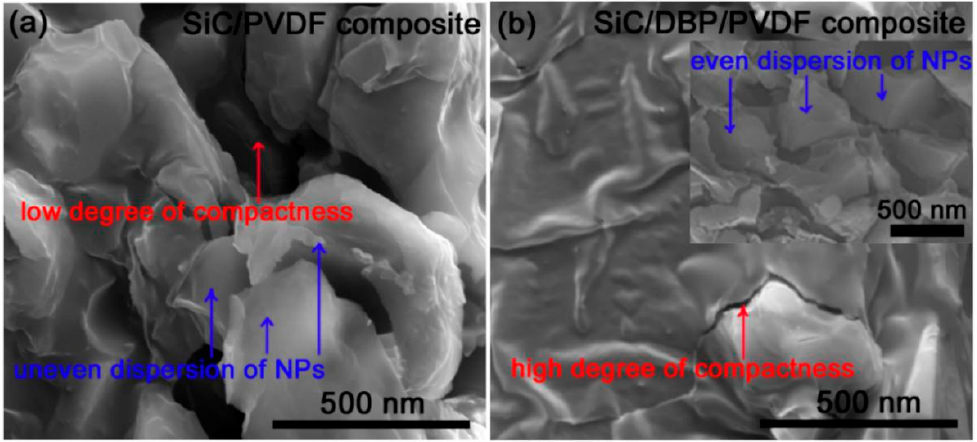
Figure 2. Cross-section SEM results confirm ( a ) the low compactness degree in interface zones of binary composite and ( b ) the high compactness degree in interface zones of ternary composite; the inset shows the even distribution of NPs, and both composites are filled with 36 vol % SiC.